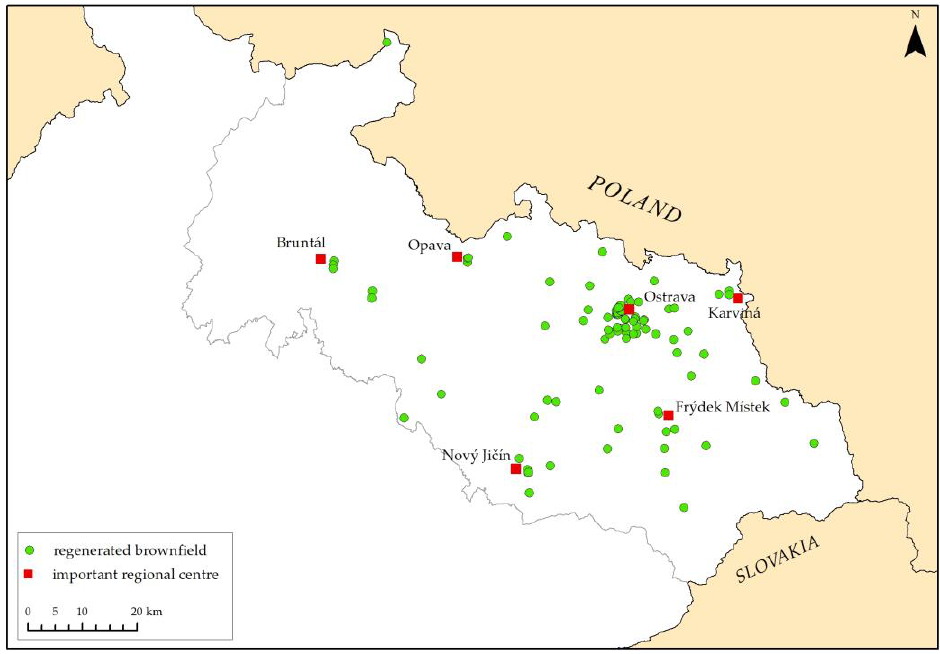
Figure 11. Spatial distribution of regenerated brownfields in the Moravian-Silesian region. Prepared by the authors [19]. by the authors